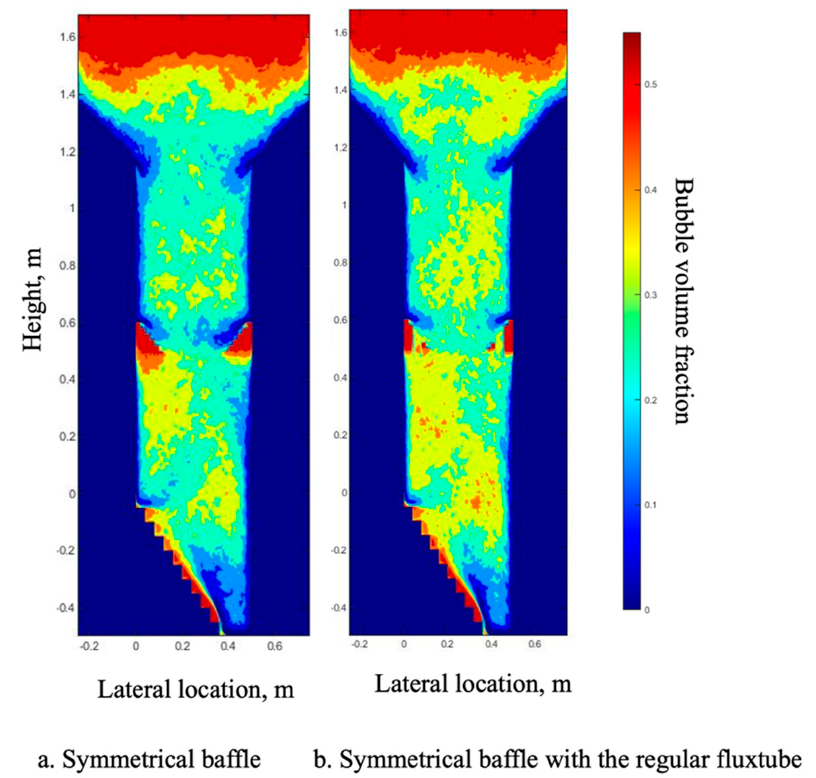
Figure 9. Gas holdup contours at the baffle zone (0.40 m < y < 0.70 m) using the symmetrical baffles with and without the regular fluxtube under the superficial gas velocity of 0.4 m/s for the even gas inlet configuration. Figure 10 indicates that the presence of the fluxtube can also increases the bubble volume fraction throughout the bed. The gas bubbles flow towards the central region and their rise velocity increases in the central region due to the symmetrical baffle with and without the fluxtube, as shown in Figure 11. The relatively high gas velocity in the central region is due to the smaller opening area between the baffle tips and large recirculation of the gas above the baffle.